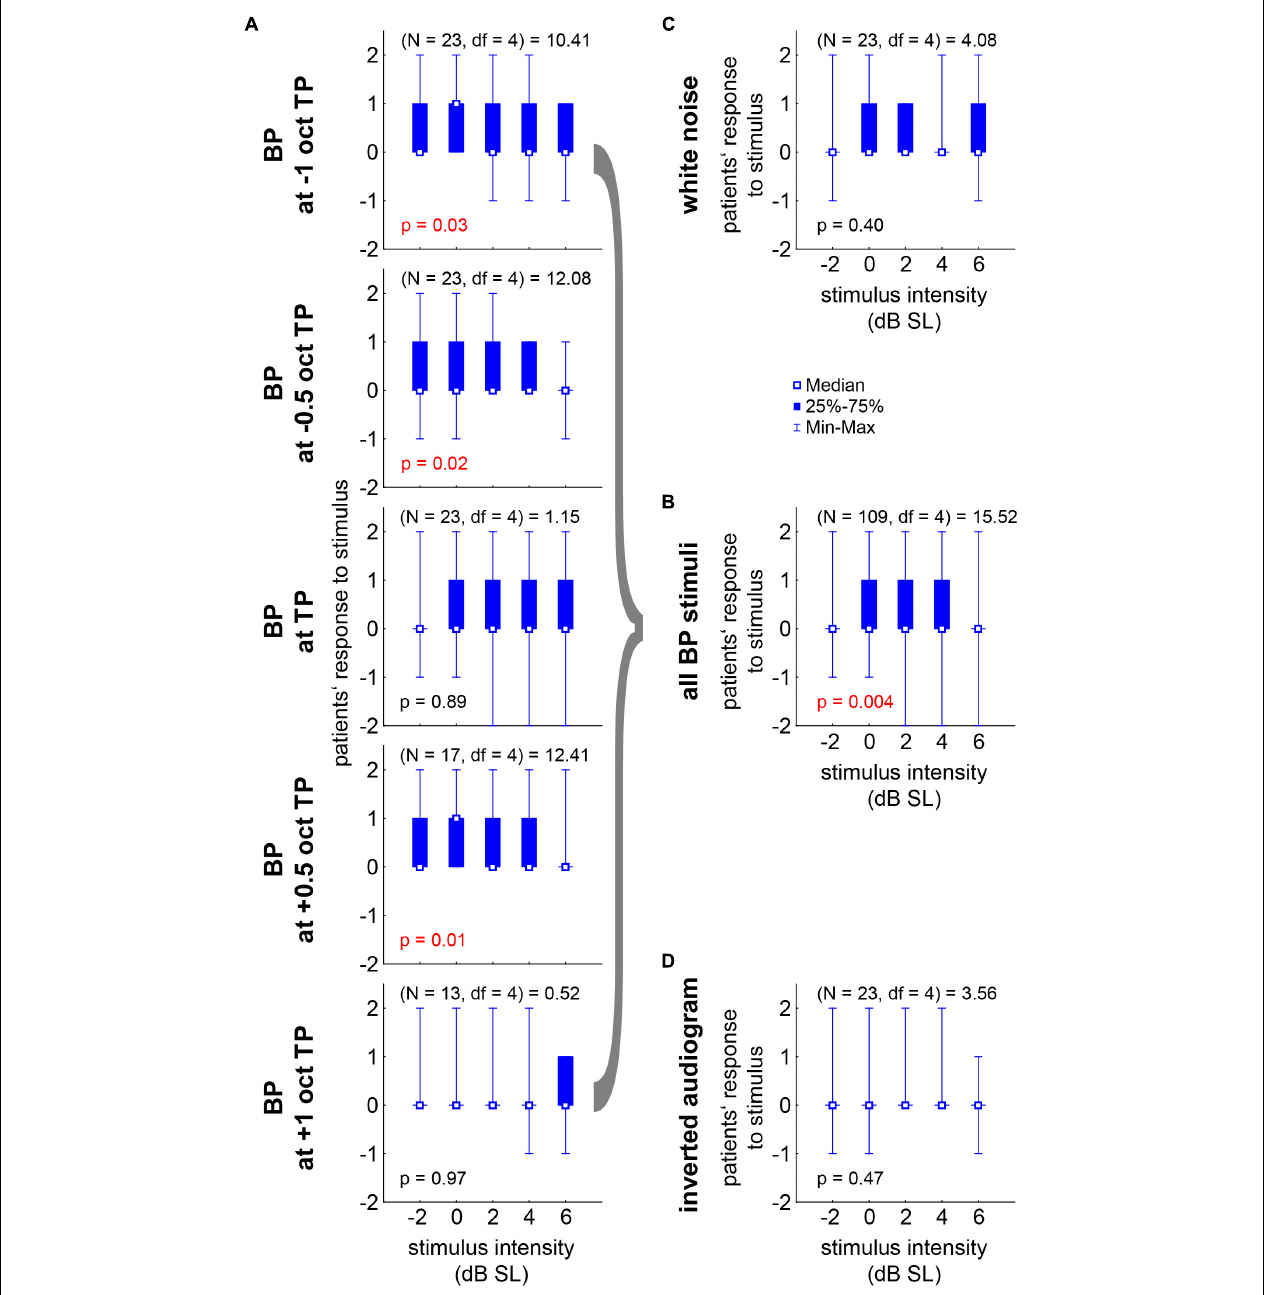
FIGURE 5 | Median responses (–2 to +2 in steps of one) to the near-threshold noise stimuli of all 21 R patients with Friedman-ANOVA statistics. (A) Responses to the five BP stimuli ranging from –1 oct to + 1 oct relative to TP across the five stimulus intensities. (B) Median responses across all BP stimuli. (C) Responses to WN stimuli. (D) Responses to the IA